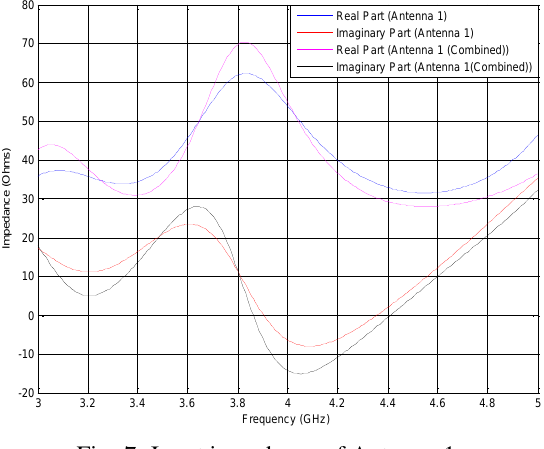
Fig. 9 :VSWR of Antenna-2.